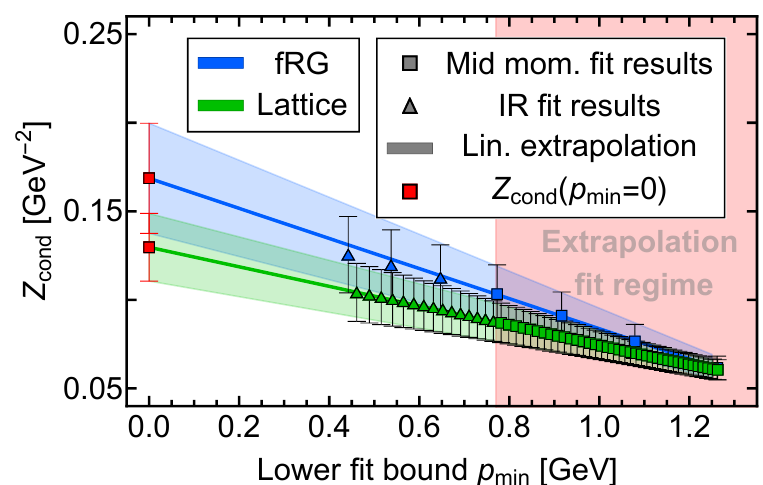
= 0, Figure 8: Linear extrapolation of Z to the lower fit interval bound p cond min = 0.149 ( 19 ) . The explicit fit results for Z yielding Z are obtained via a fit cond cond of eq. (95) to the scaling fRG data of [ 47 ] (blue squares), and to the lattice data of [ 22, 85 ] (green squares). Z , being defined as the operator product expan- cond sion coefficient should be extracted at p = 0: we extract this information from an extrapolation of the fit results towards p = 0 (red squares), and use as a minimal ≈ 0.8 GeV, below which the details of the implementation of the IR dynamics p min begin to matter. The triangular data points mark fit results for p below the fit min regime for the interpolation. The final estimate for Z (eq. (99) and eq. (74)) is cond obtained as the mean of the lattice and scaling fRG results for Z , whose numerical cond values can be found in Table